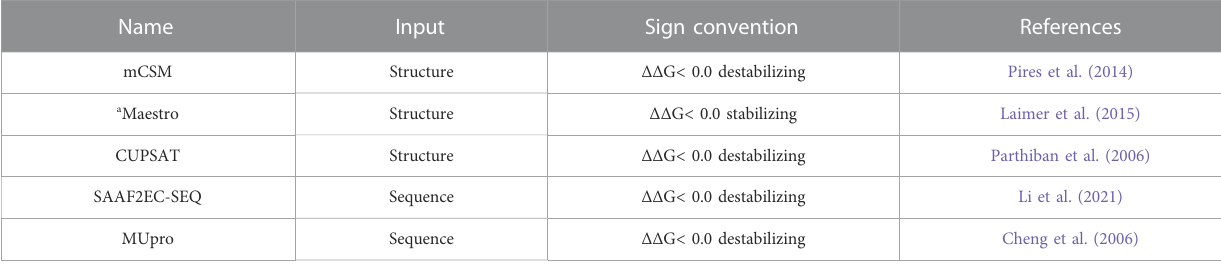
TABLE 1 Protein stability predictors used in this study.